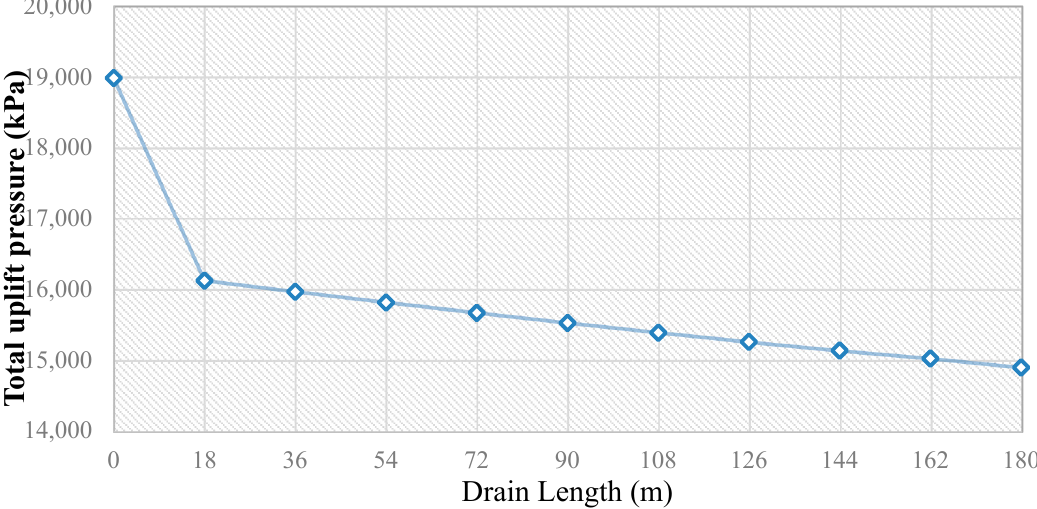
ff erent lengths for drainage system. Hydrology 2019 , 6 , x FOR PEER REVIEW